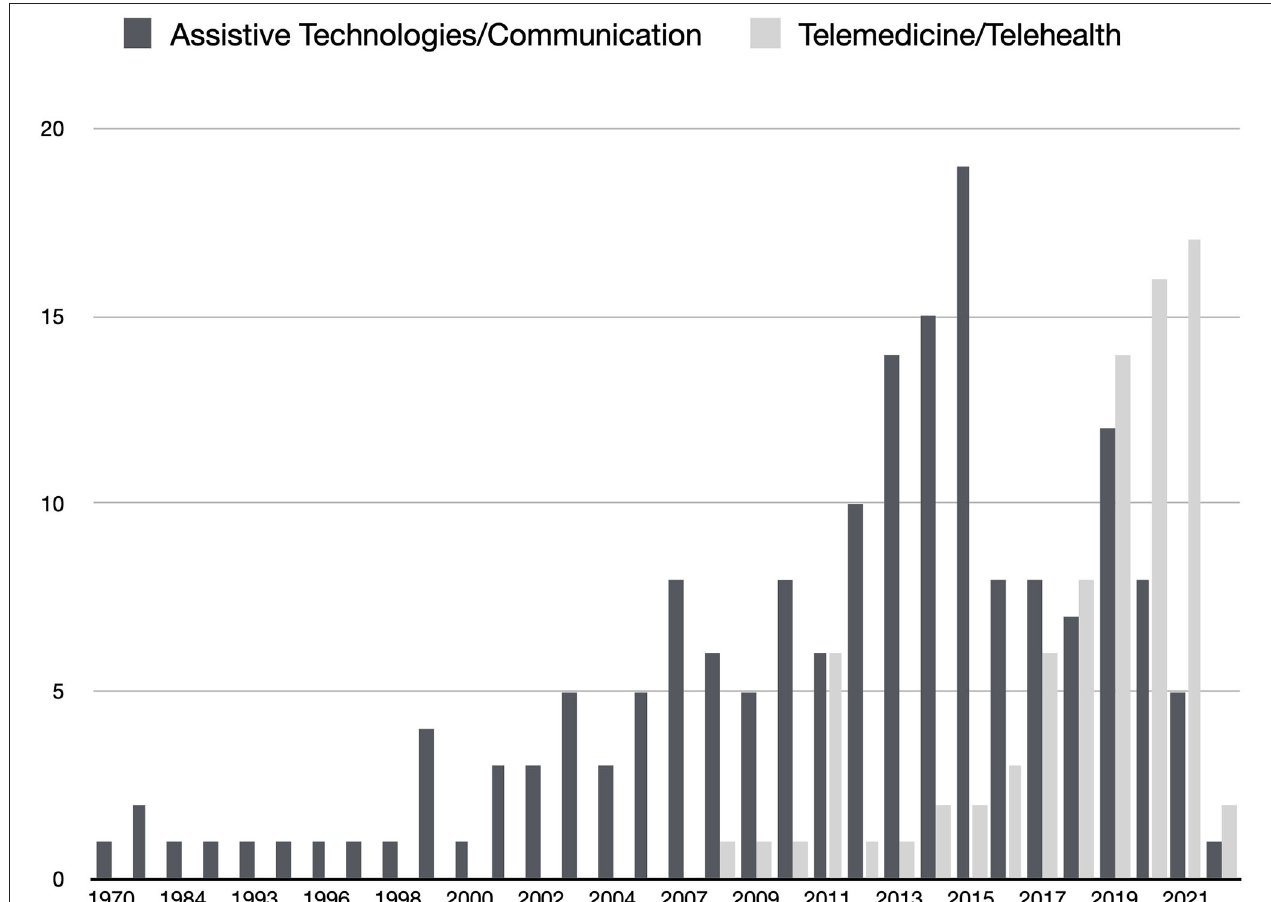
FIGURE 1 | Results of two searches in Pubmed (light gray) ((telehealth) AND (amyotrophic lateral sclerosis)) OR ((telemedicine) AND (amyotrophic lateral sclerosis)); (dark gray) ((assistive technologies) AND (amyotrophic lateral sclerosis) AND (communication)). Date of search: